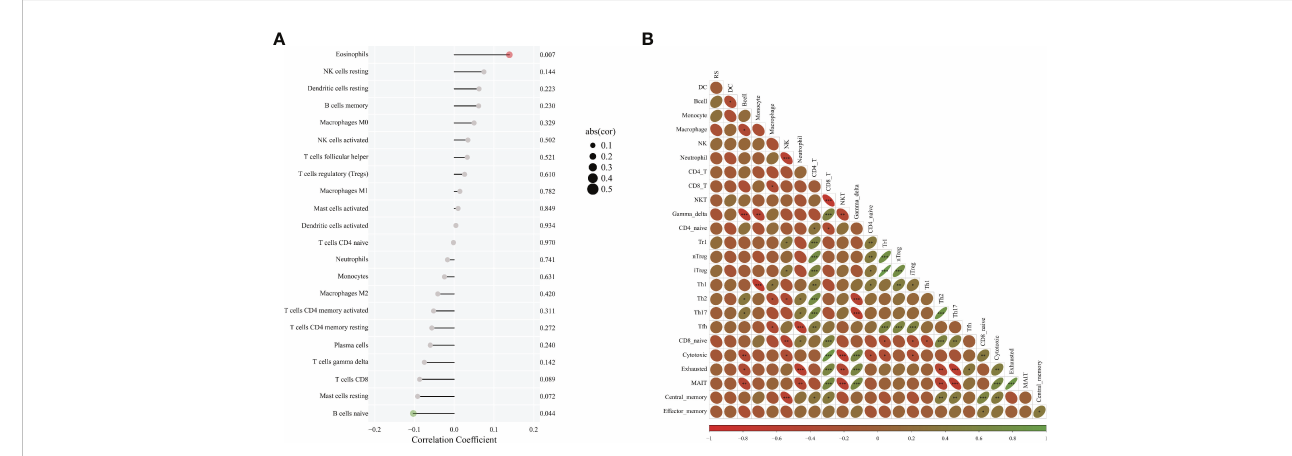
FIGURE 4 Correlation analysis of HRG and immune cell in fi ltration. (A) . Diagram of immune in fi ltration and HRG; (B) . The correlation between various immune cells. * represent p < 0.05; ** represent p < 0.01; *** represent p <